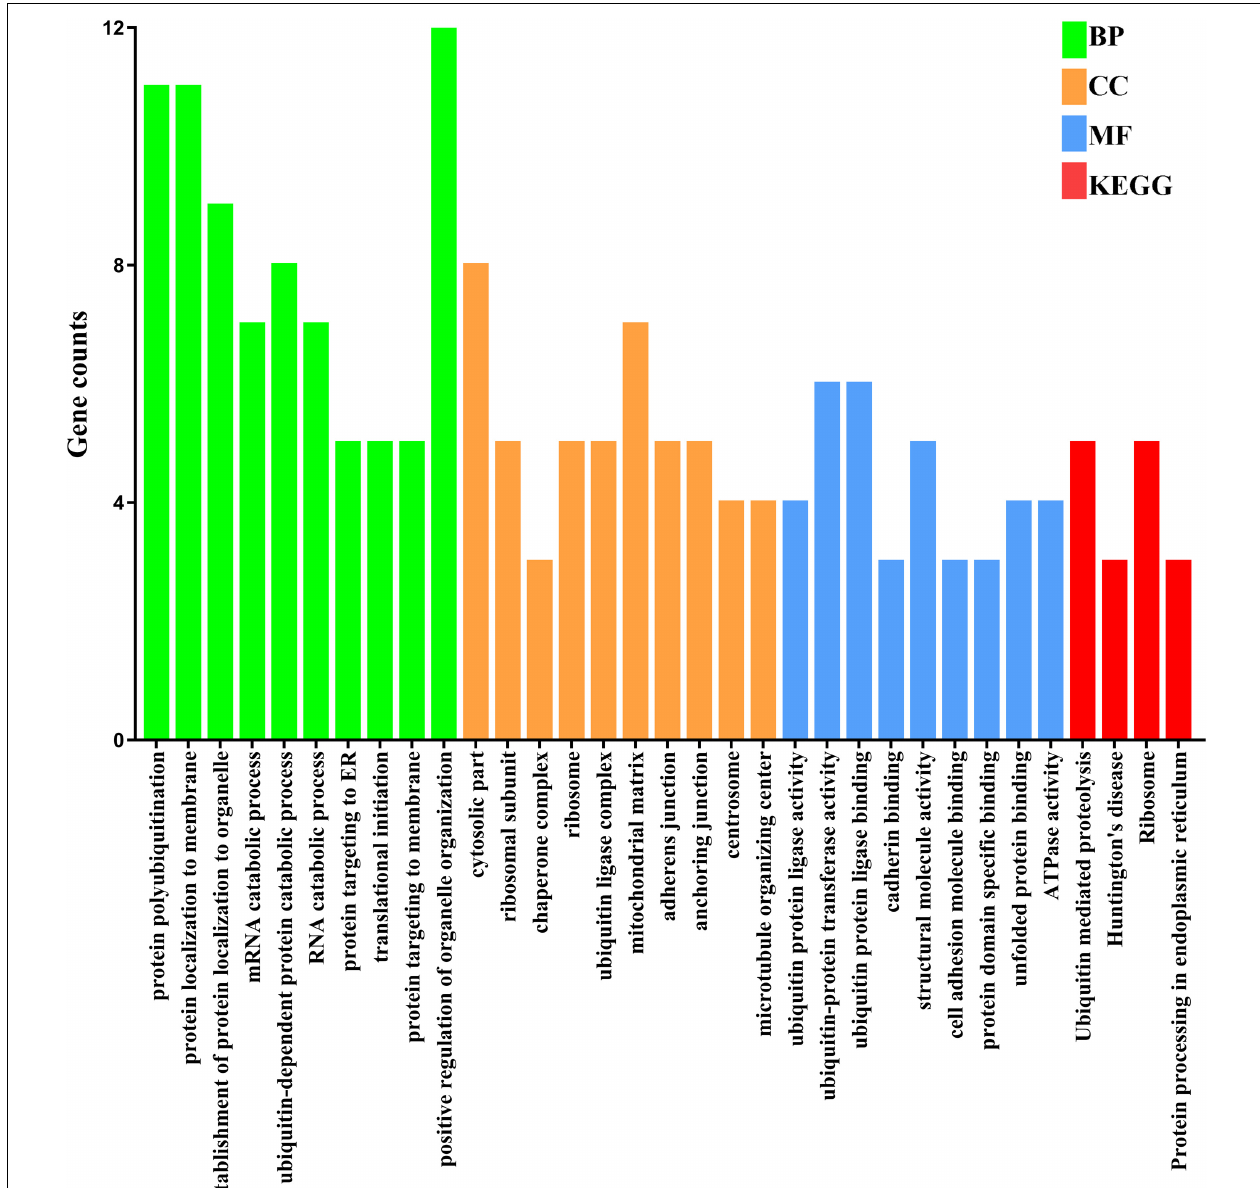
FIGURE 3 | Functional enrichment analyses of the hub genes. The numbers on the x -axis are the names of pathways or GO terms. The numbers on the y -axis are gene counts. BP, biological progress; CC, cellular component; GO, Gene Ontology; KEGG, Kyoto Encyclopedia of Genes and Genomes; MF, molecular function.